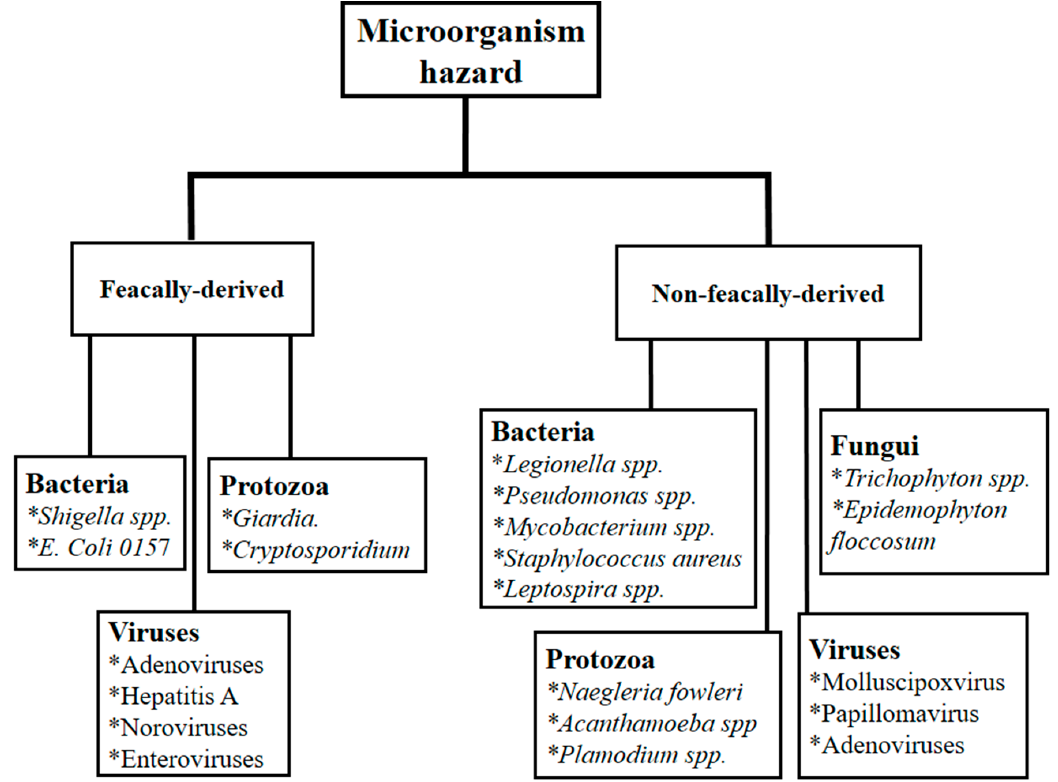
Figure 4. Potential microbial hazards in pools and similar environments. Modified from [4].